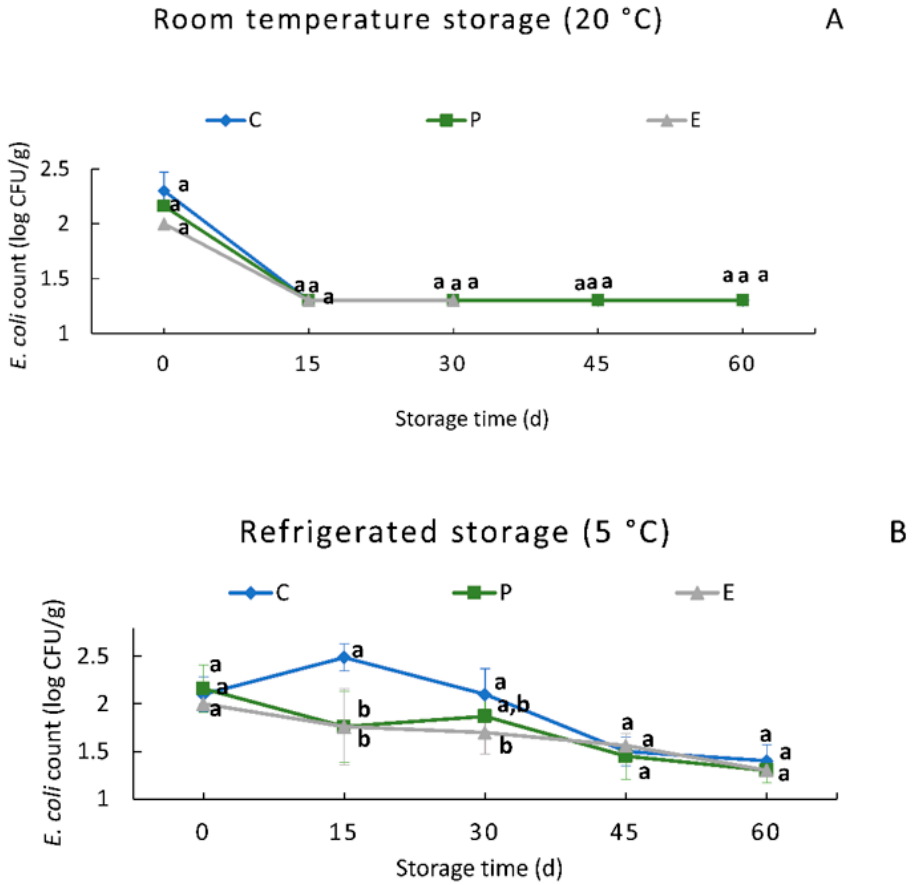
Figure 7. ( A ): E. coli counts (means ± standard deviations) during 60 d of room temperature storage (20 ◦ C) of Salamines Criollos formulated with microencapsulated L. plantarum BFL (E) and free L. plantarum BFL (P). ( B ): E. coli counts (means ± standard deviations) during 60 d of refrigerated storage (5 ◦ C) of Salamines Criollos formulated with microencapsulated L. plantarum BFL (E) and free L. plantarum BFL (P). The different letters indicate significant differences between treatments on the same day under the same storage temperature.